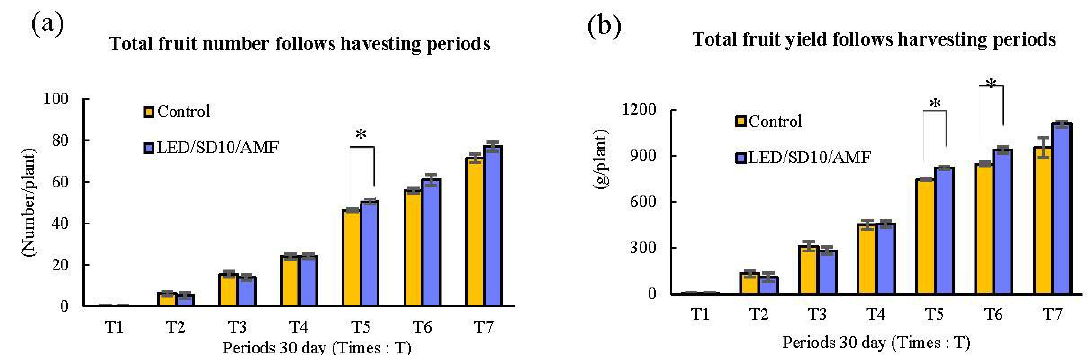
Figure 8. The effect of PGPR inoculation on LED-illuminated tomato seedlings and AMF on the seedling growth stage under greenhouse conditions for 30 days. Total fruit number ( a ), total fruit yield ( b ). Mean and standard error are calculated from three replicates. The asterisk symbol * indicates significance.